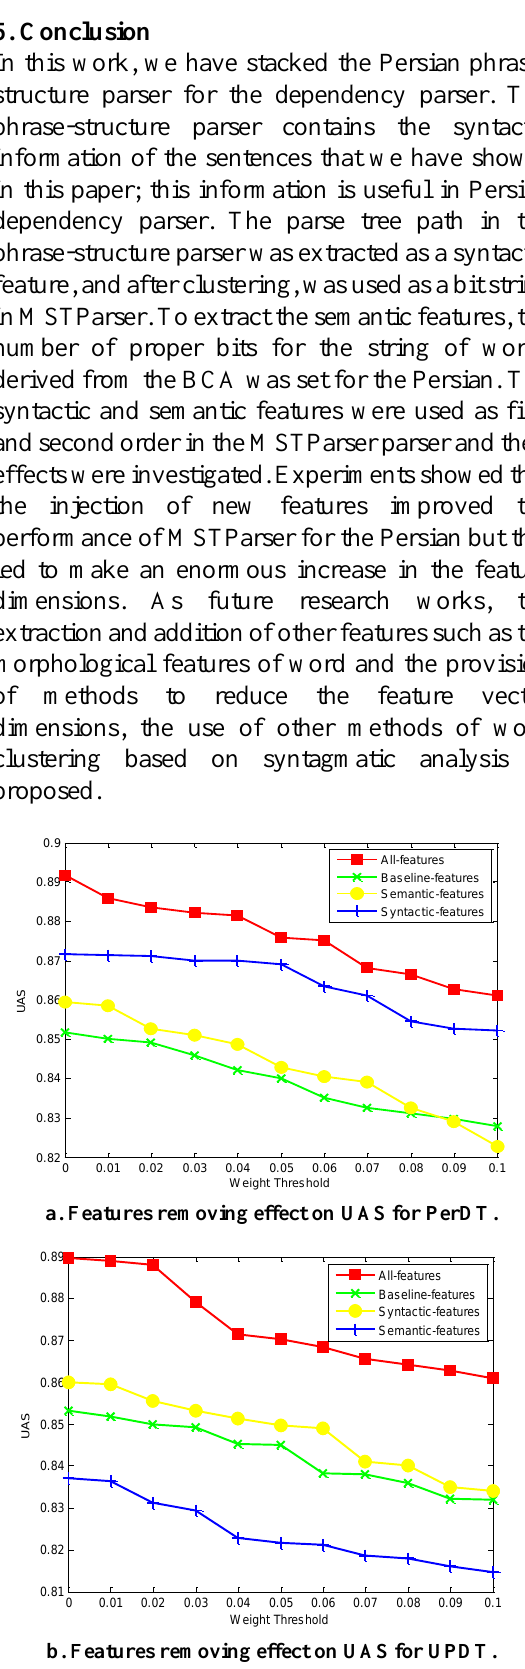
Figure 2. Results of features removing.